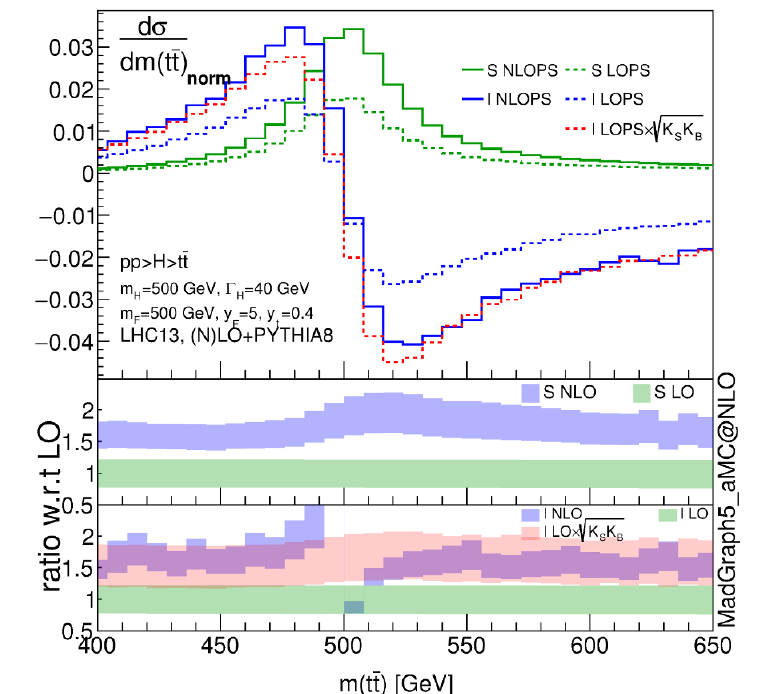
Figure 12 . Signal and interference lineshapes at (N)LO matched with PS for LHC 13 TeV. Re- sults are normalised to the SM fNLO lineshape. Lower panels show the K-factors and the scale uncertainties of signal and interference